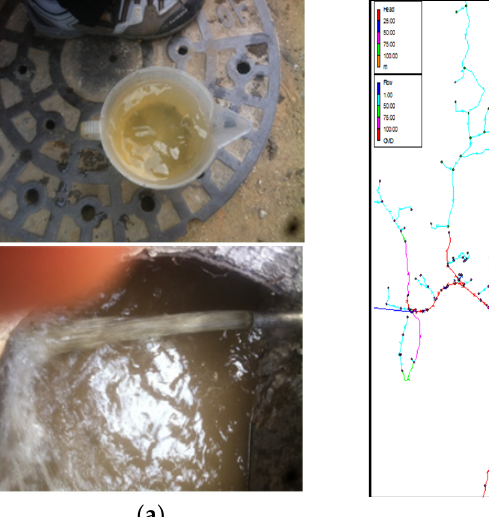
Figure 7. Discolored water and hydraulic simulation results for the PJ water distribution system. ( a ) Discolored water; ( b ) Hydraulic simulation results.